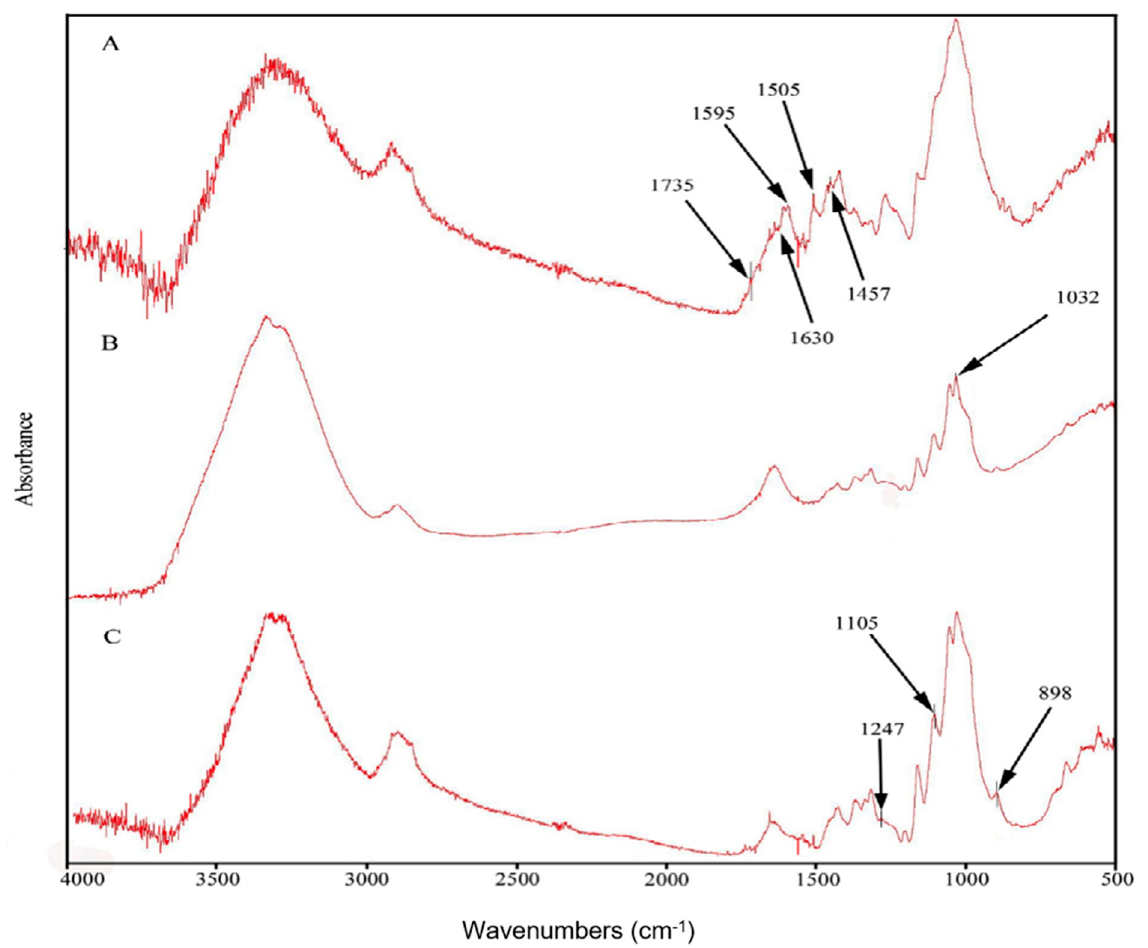
Figure 2. Fourier-transform infrared spectra of fibers ( A ), holocellulose ( B ) and cellulose ( C ) extracted from egagropili dewaxed powder. Further experimental details are given in the text.